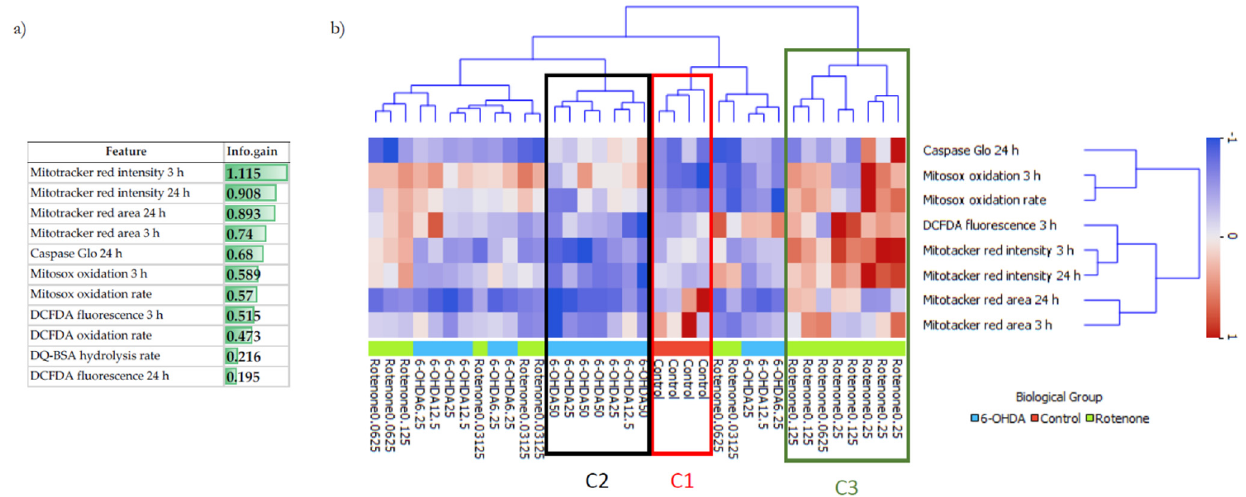
Figure 10. Hierarchical clustering, with a subset of features presenting an information gain higher than 0.5, could distinctly group control cells and cells treated with different concentrations of 6- OHDA or rotenone. Information gain analysis of the 11 features measured in this work ( a ). The tree’s leaves resulting from hierarchical clustering were labeled using both biological groups and the corresponding concentrations. The subset of features used for clustering are presented in the rows of the heatmap ( b ).